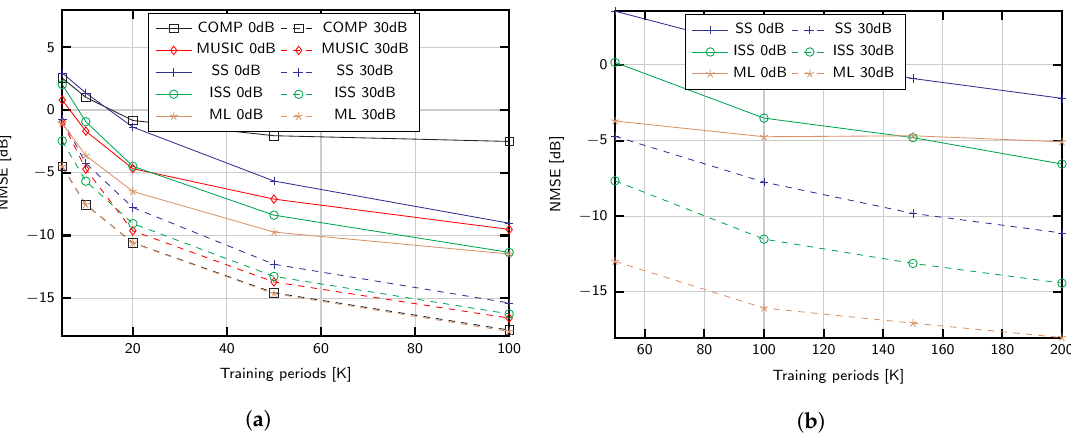
Figure 1. ( a ) NMSE of different covariance identification strategies for 400 antennas and 15 channel propagation paths. ( b ) NMSE of different covariance identification strategies for 400 antennas and 70 channel propagation